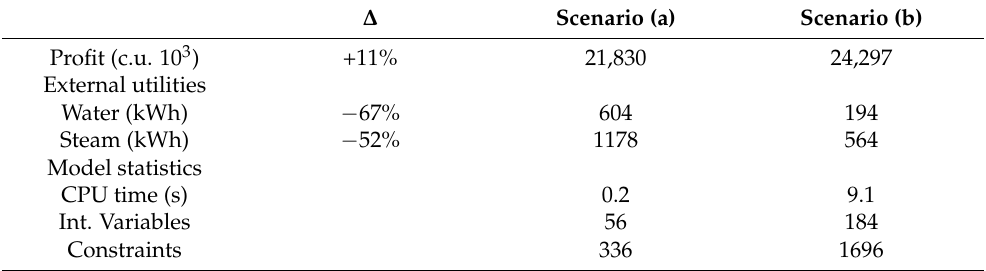
Table 5. Comparison of scenario solutions.